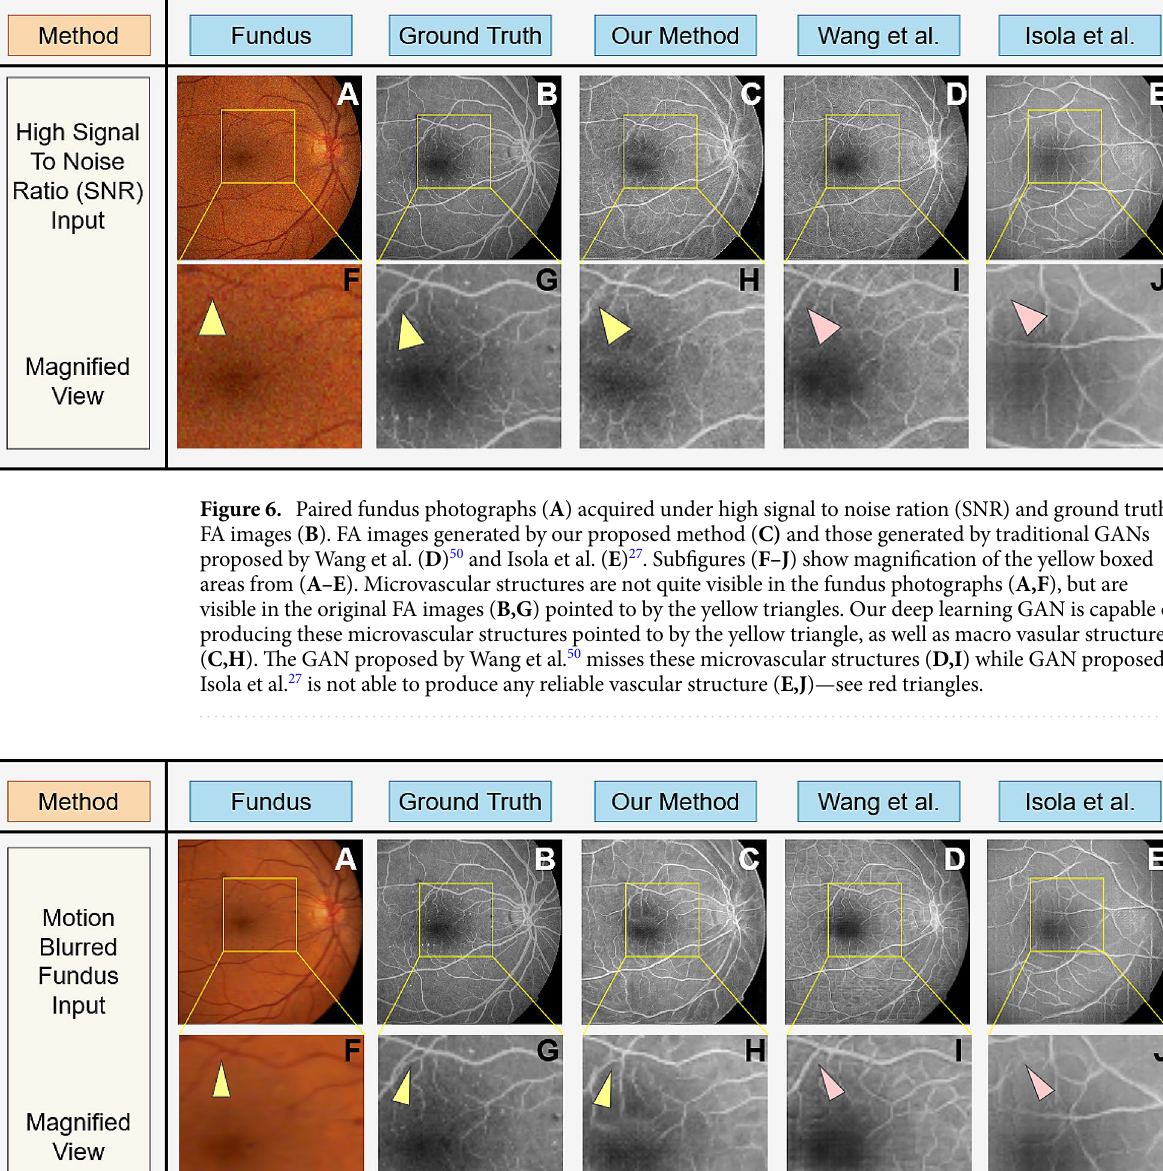
Figure 8 shows the generated FA images from fundus photographs subject to color and contrast sharpness (Fig. 8A) compared to the FA image of same subject (Fig. 8B). Using a sharpened fundus photograph as input,